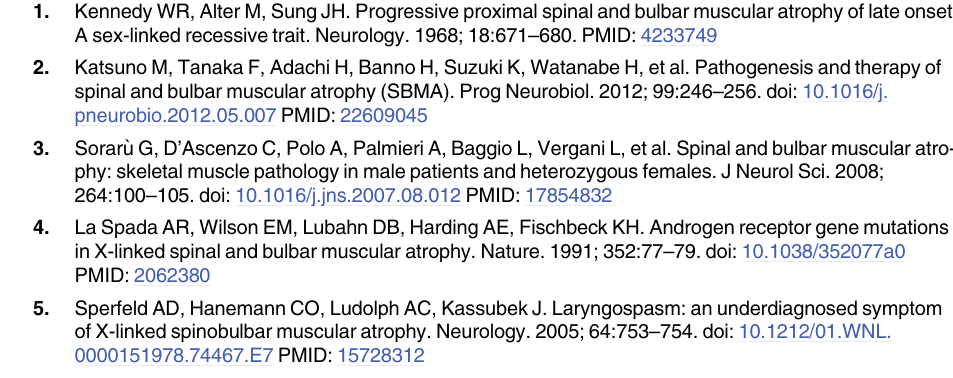
S2 Fig. Relationships between %PEF and ALSFRS-R scores in subjects with SBMA. Rela- tionships between %PEF and the total score (A) and subscores (B–F) of ALSFRS-R in SBMA. %PEF values in subjects with SBMA correlated well with the total score (A) and the trunk (D) and lower limb (E) subscores of ALSFRS-R. %PEF, predicted values of peak expiratory flow; ALSFRS-R, the revised Amyotrophic Lateral Sclerosis Functional Rating Scale; SBMAFRS, Spi- nal and Bulbar Muscular Atrophy Functional Rating